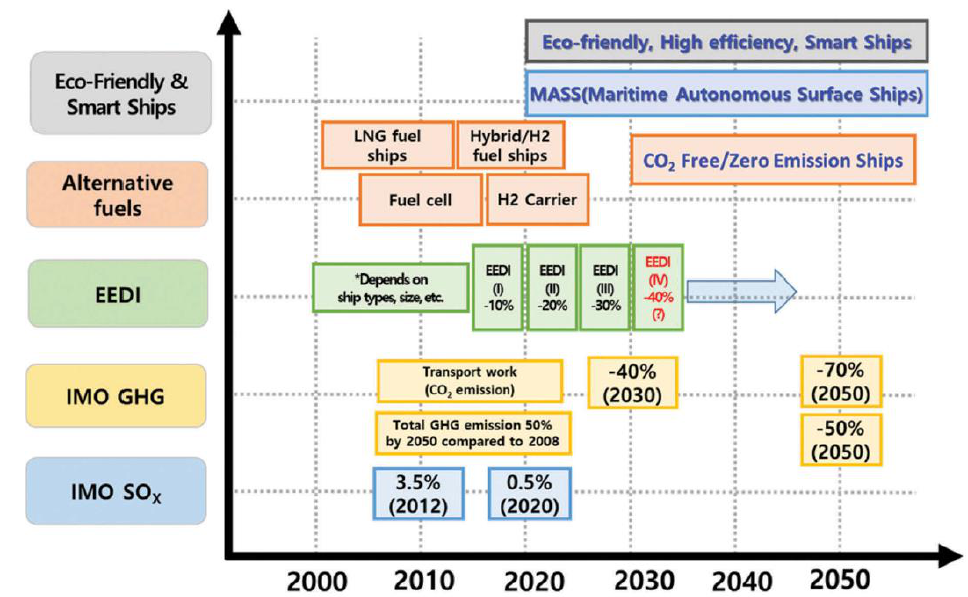
Figure 2. IMO emission reduction program from 2000 to 2050. Reprinted from ref. [12]. It has been assessed that international maritime transport has an impact between 2% to 3% of global GHG emissions, with a predicted increment by up to 50% by 2050. According to the Fourth IMO GHG Study of 2020, GHG emissions from total shipping (i.e., produced by international, domestic, and fishing) has raised from 977 M tonnes in 2012 to 1076 M tonnes in 2018 (9.6% growth), of which 962 M tonnes in 2012 and 1056 M tonnes in 2018 were CO 2 emissions (9.3% growth). Moreover, IMO forecasts predict that emissions will increase by 90 to 130% before 2050 against 2008 values [13]. As a consequence, IMO has been developing specific strategies [12,14] in order to reduce shipping GHG emissions by at least 50% before 2050; besides, the European Commission aims to reduce the GHG emissions generated from European transport as a part of a larger environmental vision called the “European Green Deal” [2]. In order to reduce shipping GHG emissions, IMO has tightened regulations about air pollution in 2010, also introducing special geographical areas where emissions shall be limited more strictly, known as Special Emission Control Areas (ECAs or SECAs). In Europe, these areas are located in the Baltic and Northern Seas. The difference in SO x and NO x depositions for 2014 and 2016 for the Baltic Sea region was modelled calculating also the financial impact, to understand what the effects of enforcing Sulphur Emission Regulations (SECA) were in 2015; it has been found that the local SO x deposition values decreased by 7.3%, with SO x depositions generated by ships dropping from 38 kt to 3.4 kt, meaning USD 130 M in terms of financial impact on the environment. NO x depositions have not shown any significant reduction [15]. Figure 3 below shows the geographical extension of ECAs in Baltic and North